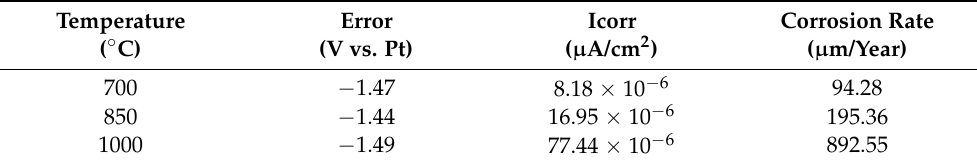
Figure 2. Potentiodynamic curves correspond for the substrate evaluated at 700 °C, 850 °C, and 1000 °C. Table 1. The corrosion potential, current density, and corrosion rate were obtained for the steel substrate at 700 °C, 850 °C, and 1000 °C.